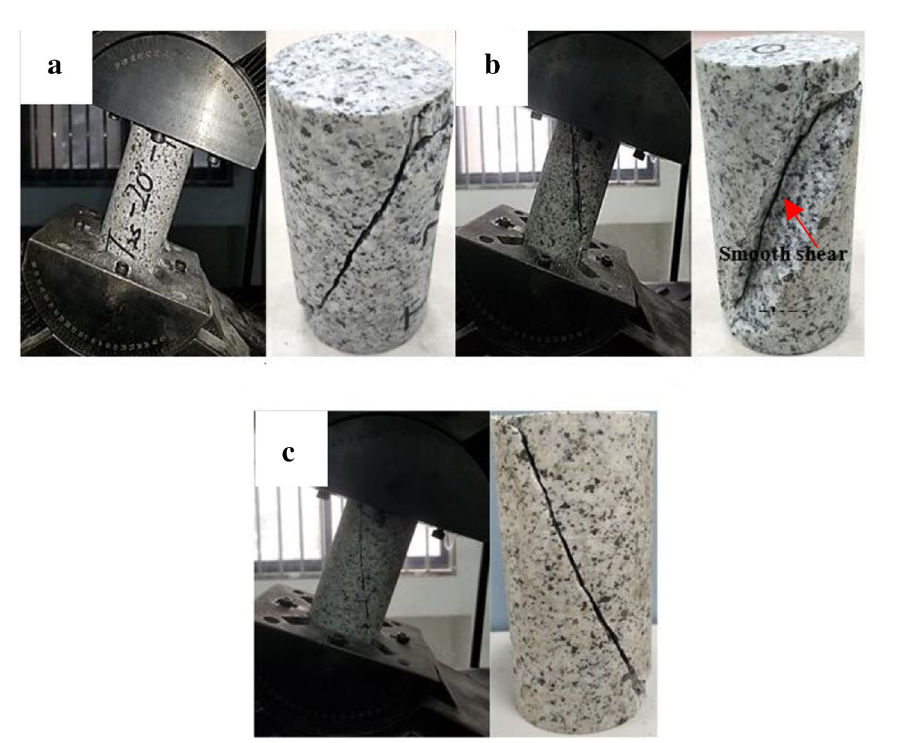
Figure 5. Granite specimen failure pattern at an inclination angle of 20°: ( a ) Experimental case 4–1; ( b ) experimental case 4–2; and ( c ) experimental case